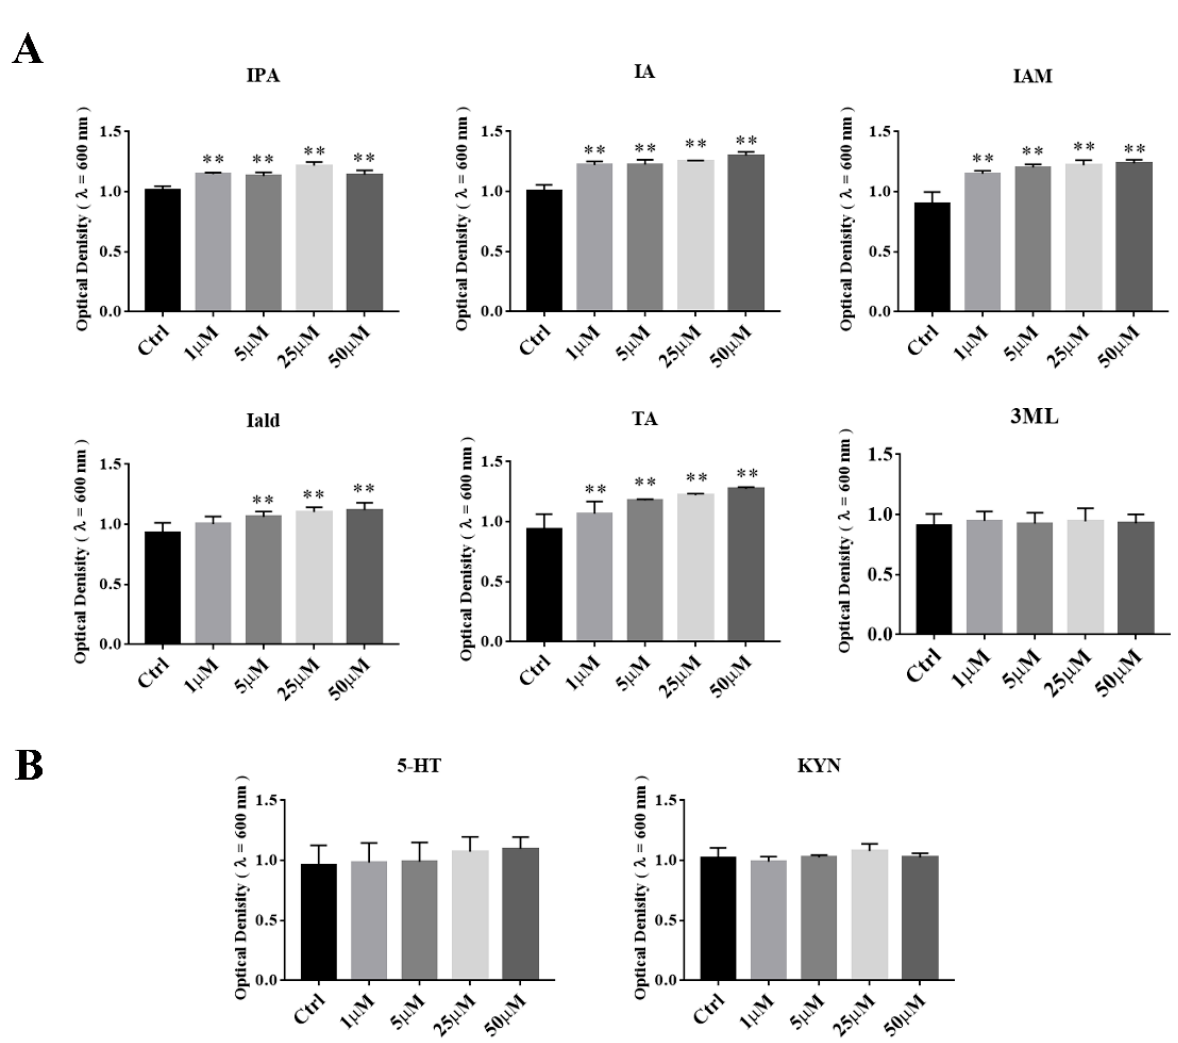
Figure 6. Effects of tryptophan metabolites produced by other gut microbiota on growth of A. muciniphila BAA-835 T . ( A ) Indole and indole derivatives produced by gut microbiota. ( B ) 5-HT and KYN. One-way ANOVA with a post hoc Dunnett test was used to determine statistical differences, compared with the Ctrl group. ** p < 0.01.